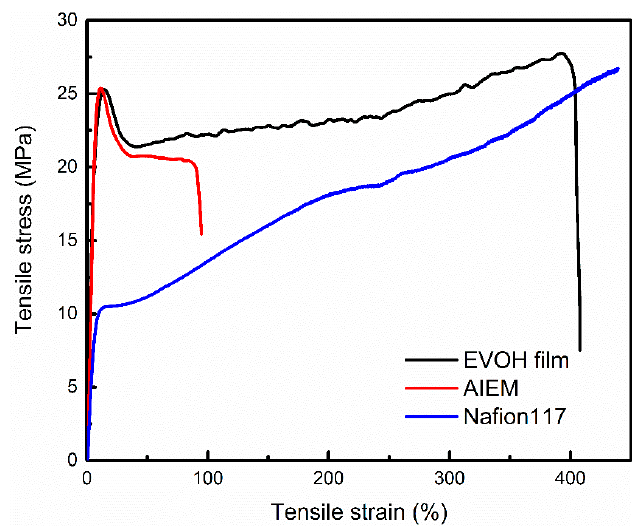
Figure 6. Stress-strain properties of the EVOH membrane, AIEM (GY = 40.9%) and Nafion117 membrane.